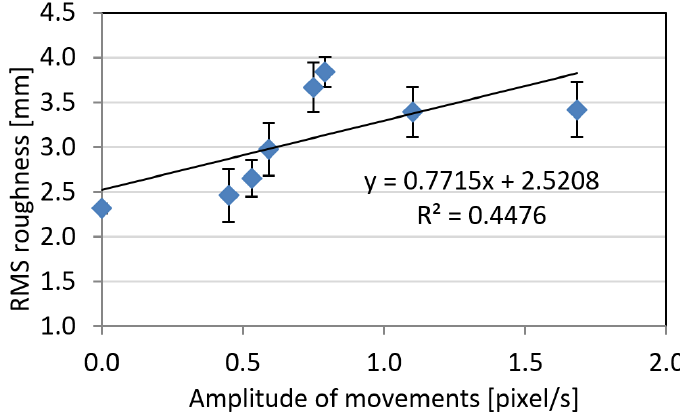
Figure 4. RMS roughness as a function of amplitude of movements. Error bars represent standard deviation on three different reconstructions.